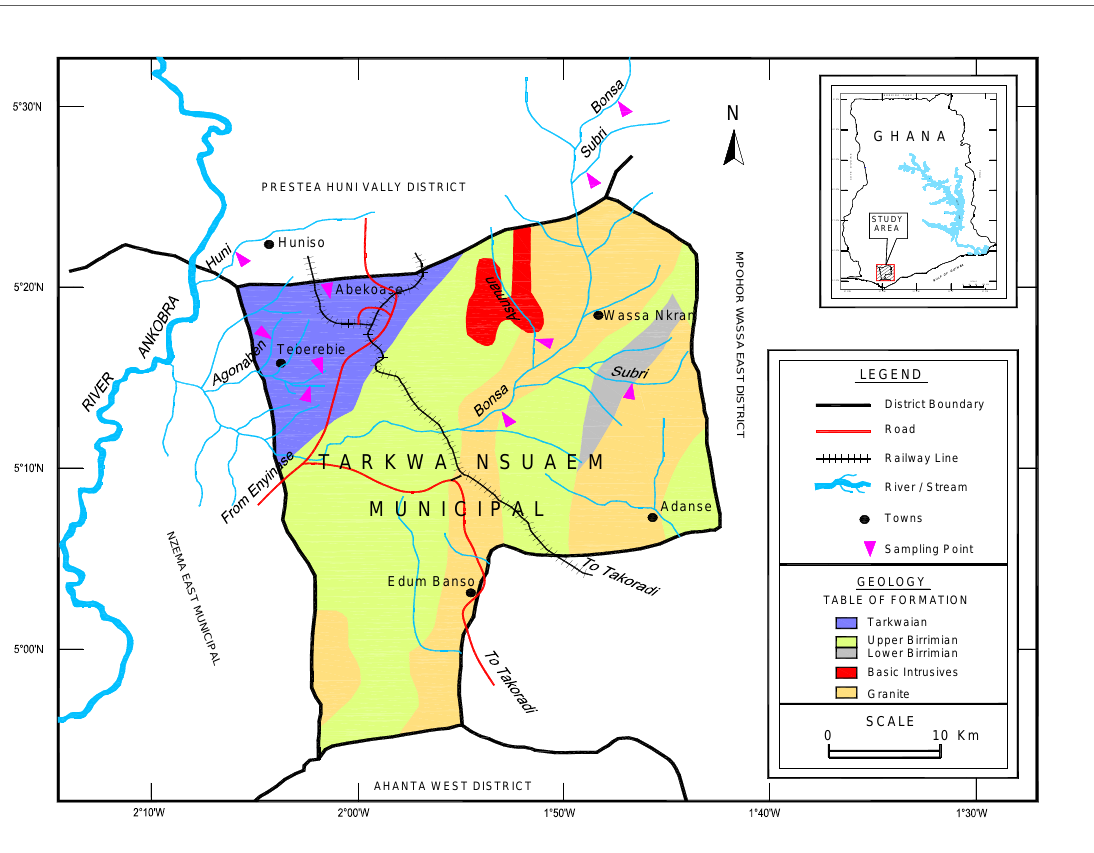
Figure 1. Map of the study area.